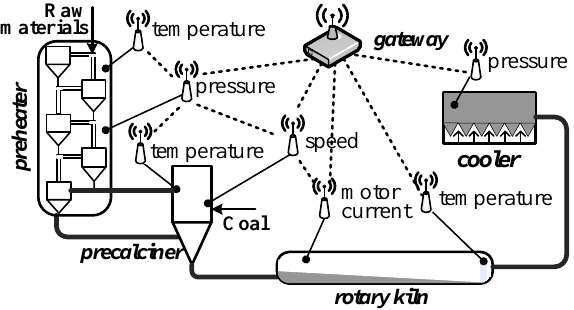
Figure 1. An industrial wireless sensor network in a cement